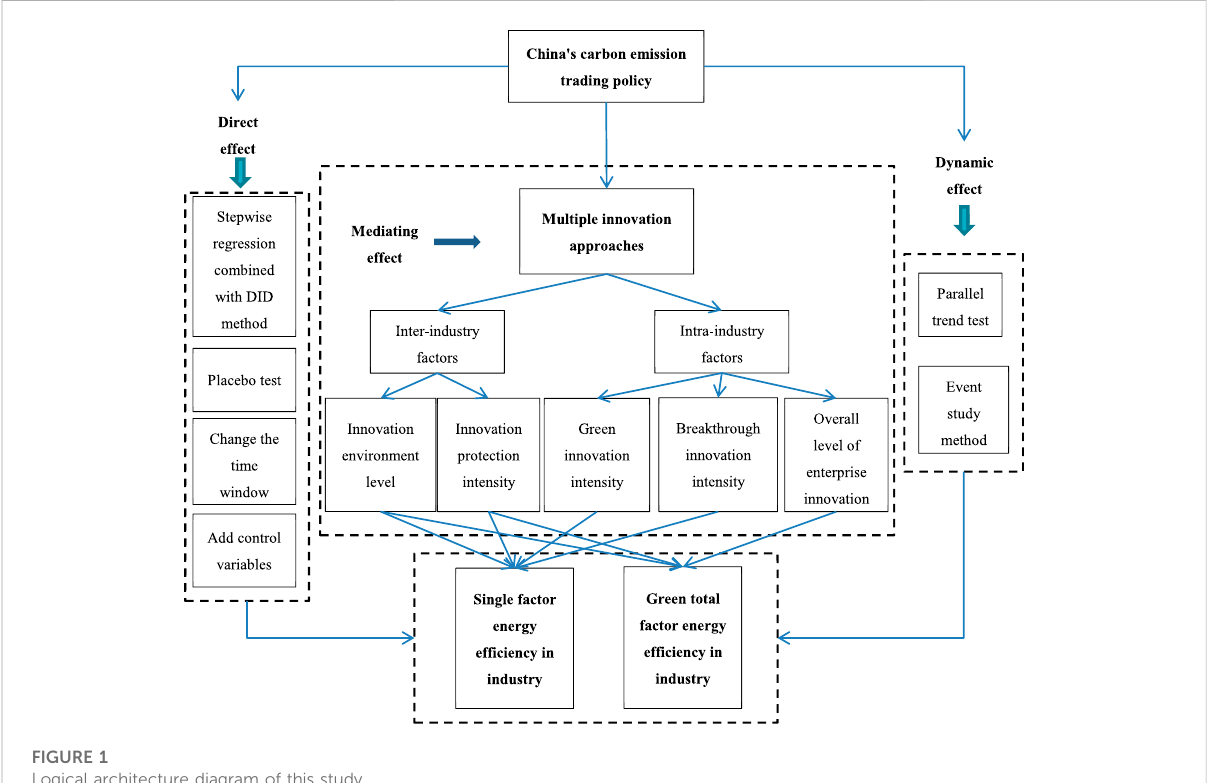
FIGURE 1 Logical architecture diagram of this